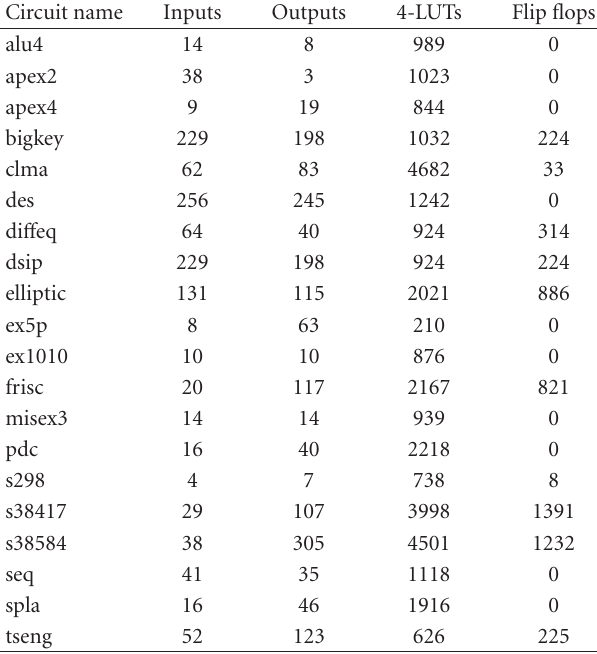
Table 1: Benchmark